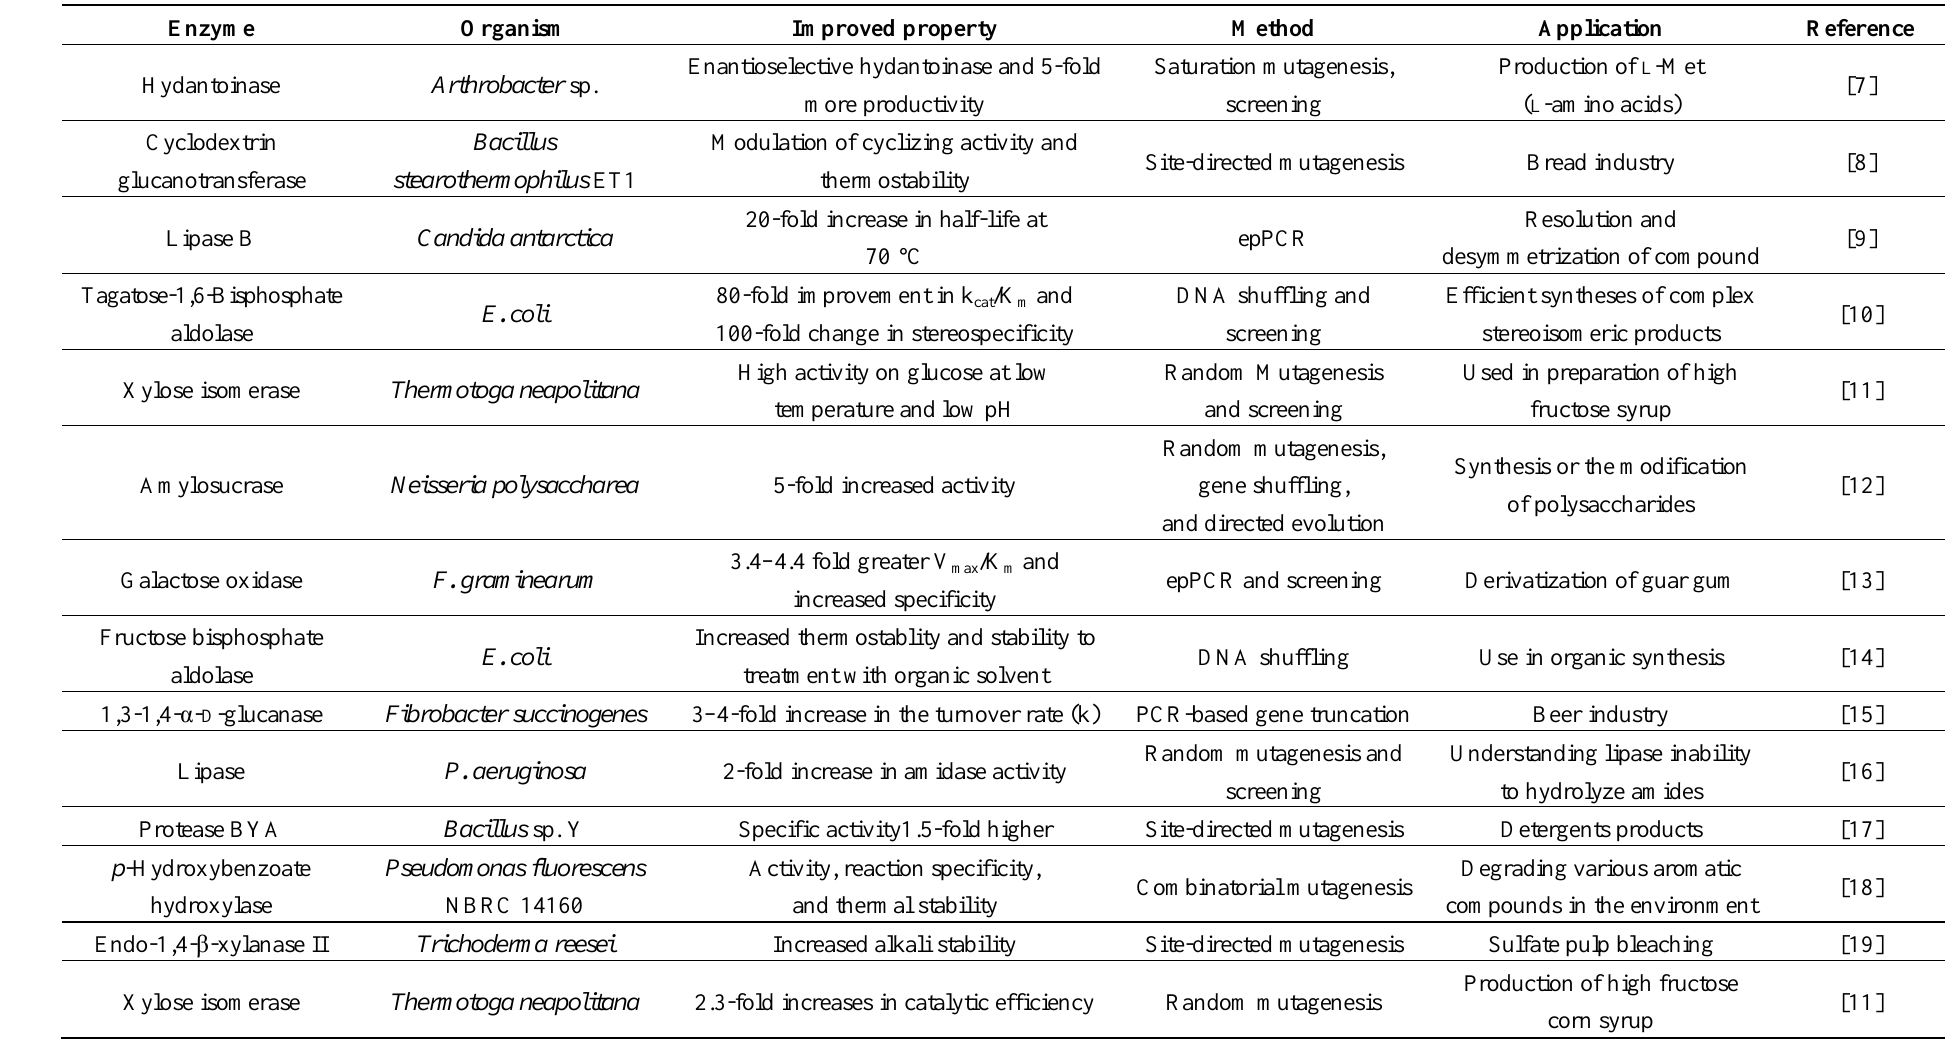
Table 1. List of the enzymes engineered by protein